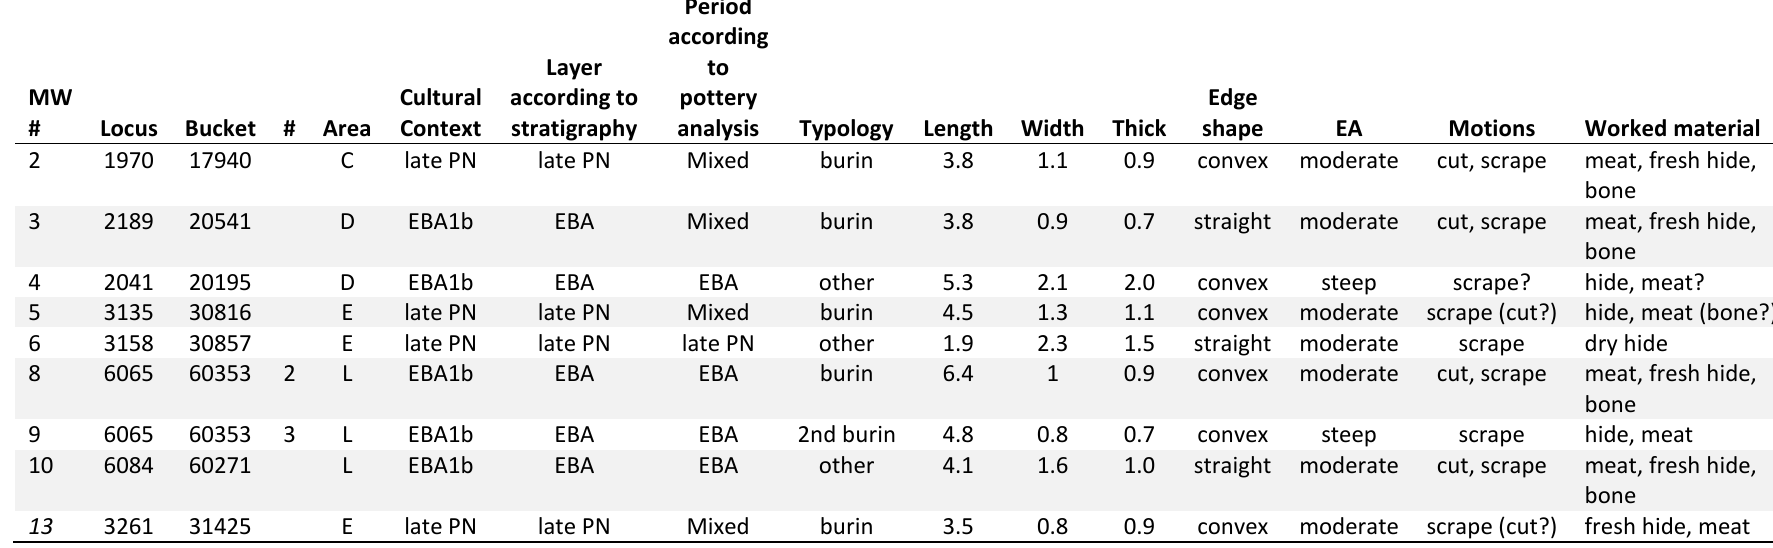
Table 2. Ein Zippori fan scraper spalls microwear results. Abbreviations: Loc. = Locus, Buck. = Bucket; late PN = late Pottery Neolithic Wadi Rabbah, EBA = Early Bronze Age1b, cultural period based on stratigraphy and pottery analysis, TS = mixed surface; FCFS = flat cortex fan scraper with flat dorsal face, CFS = cortical fan scraper with convex dorsal face; GL = greatest length, GW = greatest width, Th = thickness in mm; elong. = elongated, frag. = fragment, irreg. = irregular shapes; m = moderate, srp = sharp, stp = steep